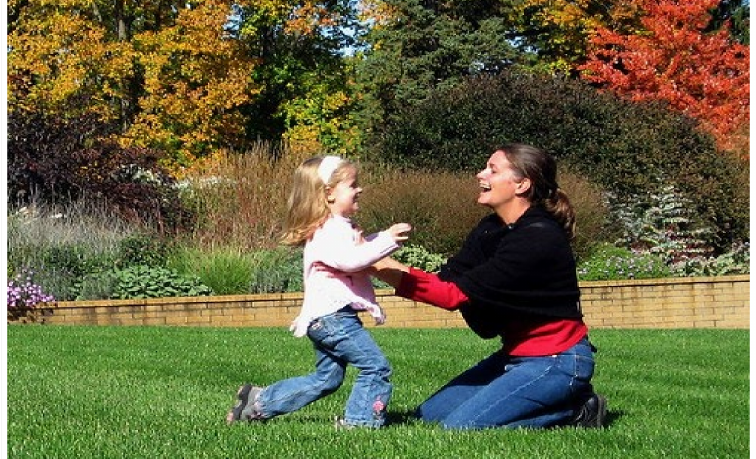
Figure 8. A sample input image from the dataset.